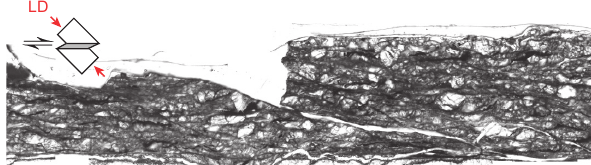
Figure 4. Shear zone overview. Micrograph of sample 492, plane polarized light. Strain localizes into a network of shear bands, anas- tomosing around low strain lenses identifiable by the large porphy- roclasts. Sketch in the upper left shows the orientation of the micro- graph with respect to the loading direction (LD) of the sample setup (Appendix Fig.